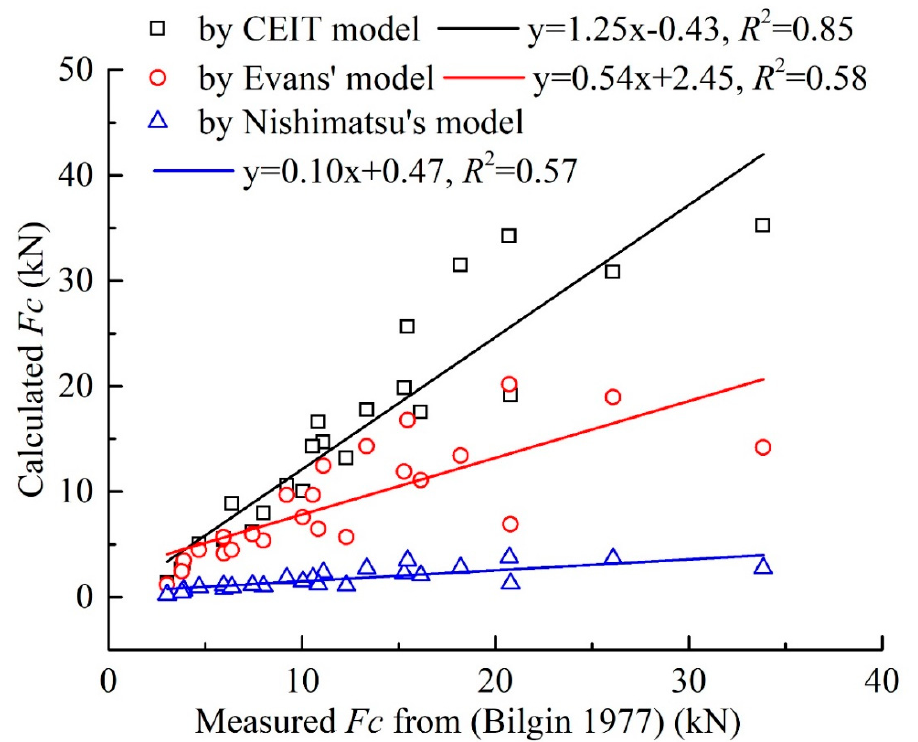
Figure 13. Comparison of the performance of different models in estimating the peak cutting forces in cutting granite.